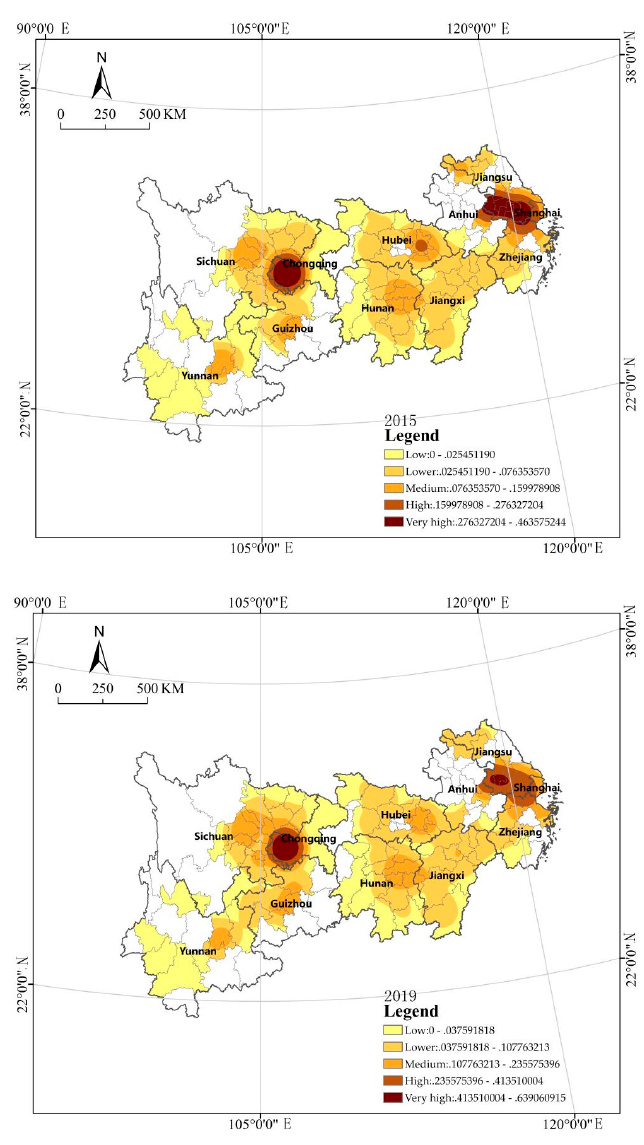
Figure 4. Kernel density analysis of the park area ( 2015–2019 ) .